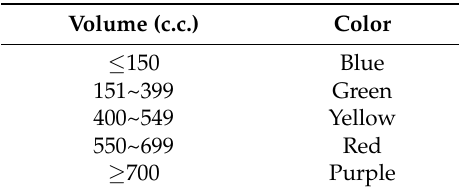
Table 1. Voided volume range and color bar of each clean intermittent catheterization (CIC) show on app.